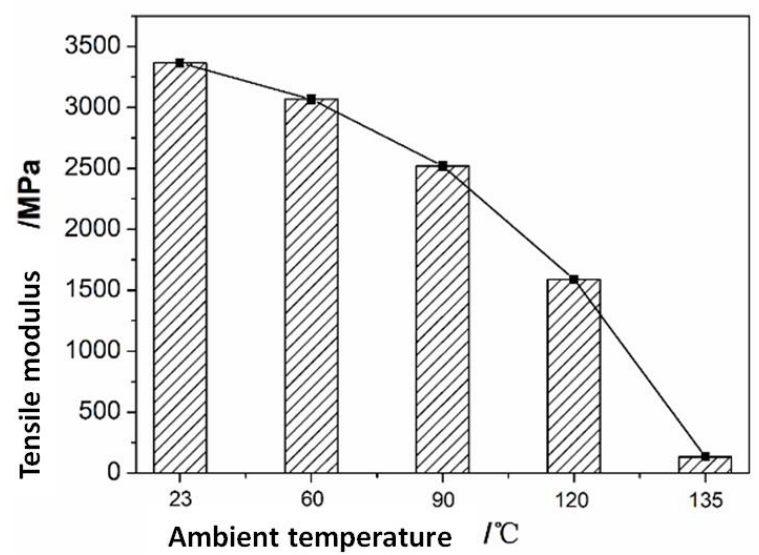
Figure 11. Resin modulus vs. ambient temperature.